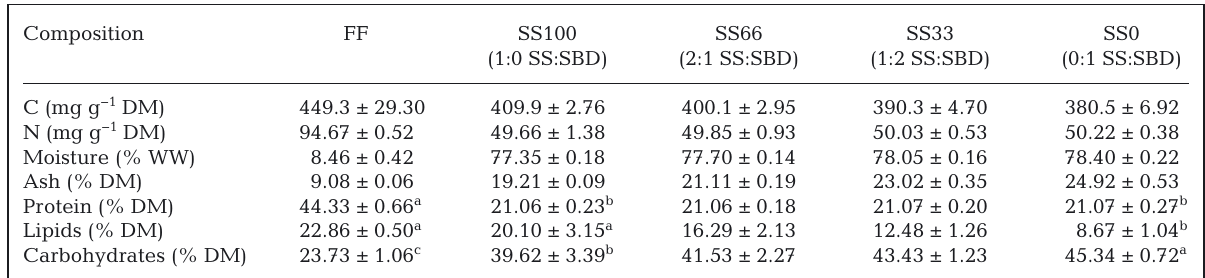
Table 1. Proximate components of the different Hediste diversicolor diets used in the 30 d feeding trial, shown as either % dry matter (DM), mg g −1 of DM or % wet weight (WW) (mean ± SD; n = 3 replicates). FF: fish feed; SS: smolt sludge; SBD: solid biogas digestate. Numbers following treatment type indicate feed ratio (SS100: pure SS; SS66: 2:1 mix of SS and SBD; SS33: 1:2 mix of SS and SBD SS0: pure SBD). Superscripts denote statistically significant differences between FF, SS100 and SS0 treatments. SS66 and SS33 were calculated from the mean and SD of SS100 and